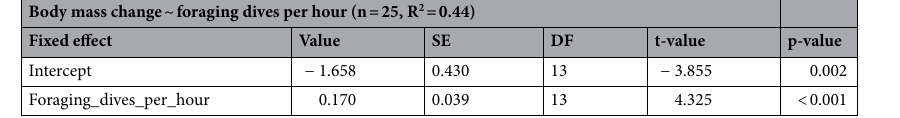
Table 2. Output of the best model fitted using restricted maximum likelihood estimation with bird ID as a random effect. R 2 = marginal r-squared value for mixed models from Nakagawa et al. 59 .